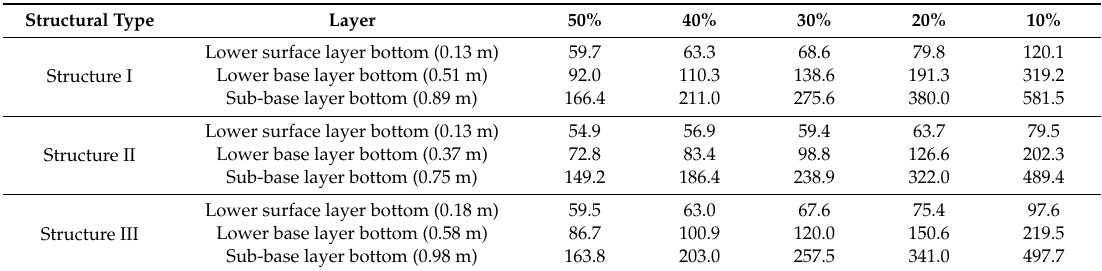
Figure 8. Envelope of transfer path under different thresholds of the three pavement structures. Table 8. Equivalent envelope area (unit: cm 2